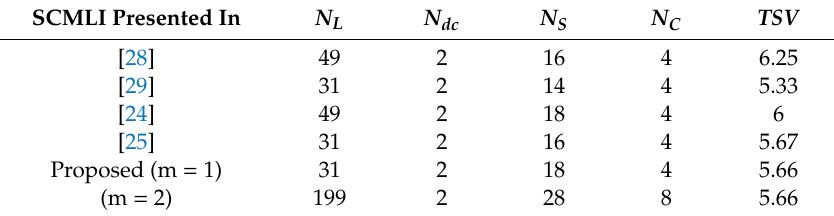
Table 5. Comparison of proposed with other asymmetric SCMLI.